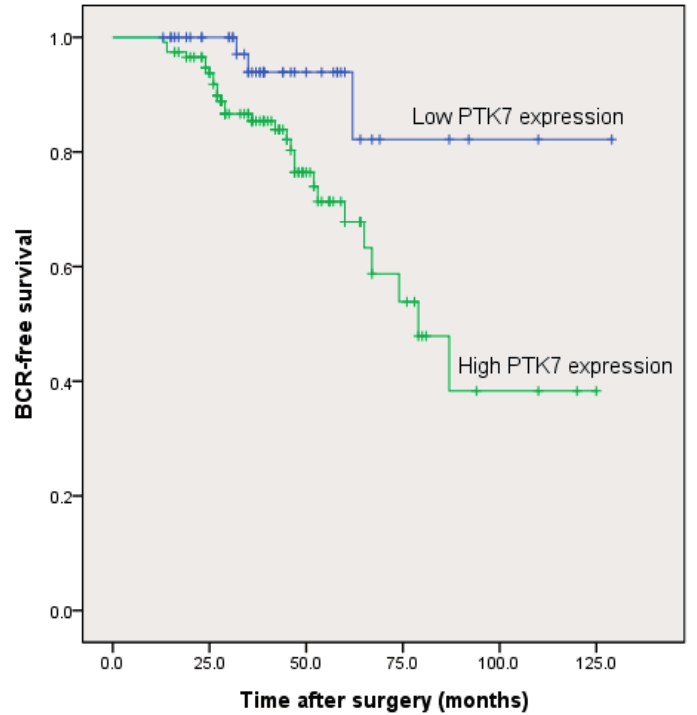
Figure 3. Associations between PTK7 expression and biochemical recurrence free time after radical prostatectomy in prostate cancer patients. Patients with high PTK7 expression showed significantly shorter biochemical recurrence free survival than those with low PTK7 expression ( p < 0.001, log-rank test).